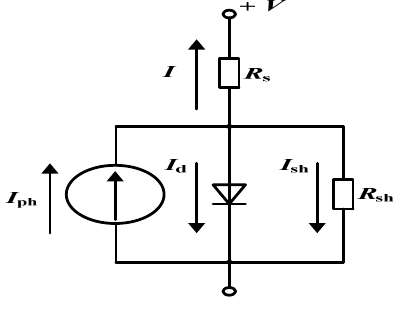
Figure 1. Single diode model of solar